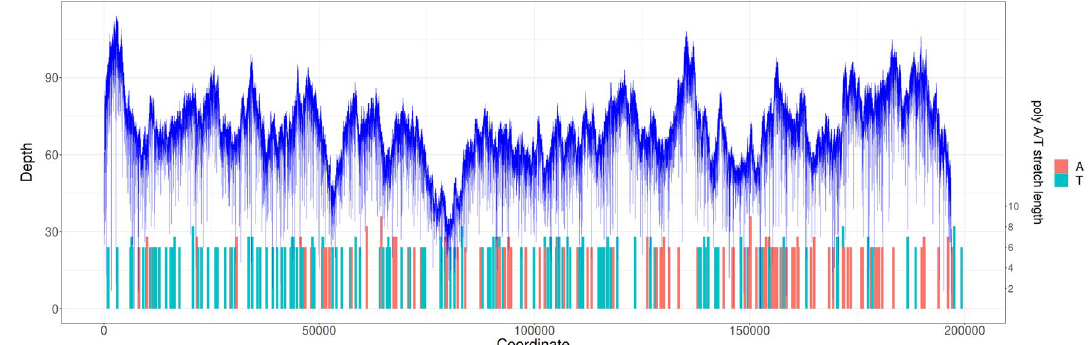
Figure 3. Genome sequencing coverage and location of A/T homopolymers in the monkeypox virus (MPXV) genome. Homopolymer repeat length at each homopolymer position (coordinates) in the